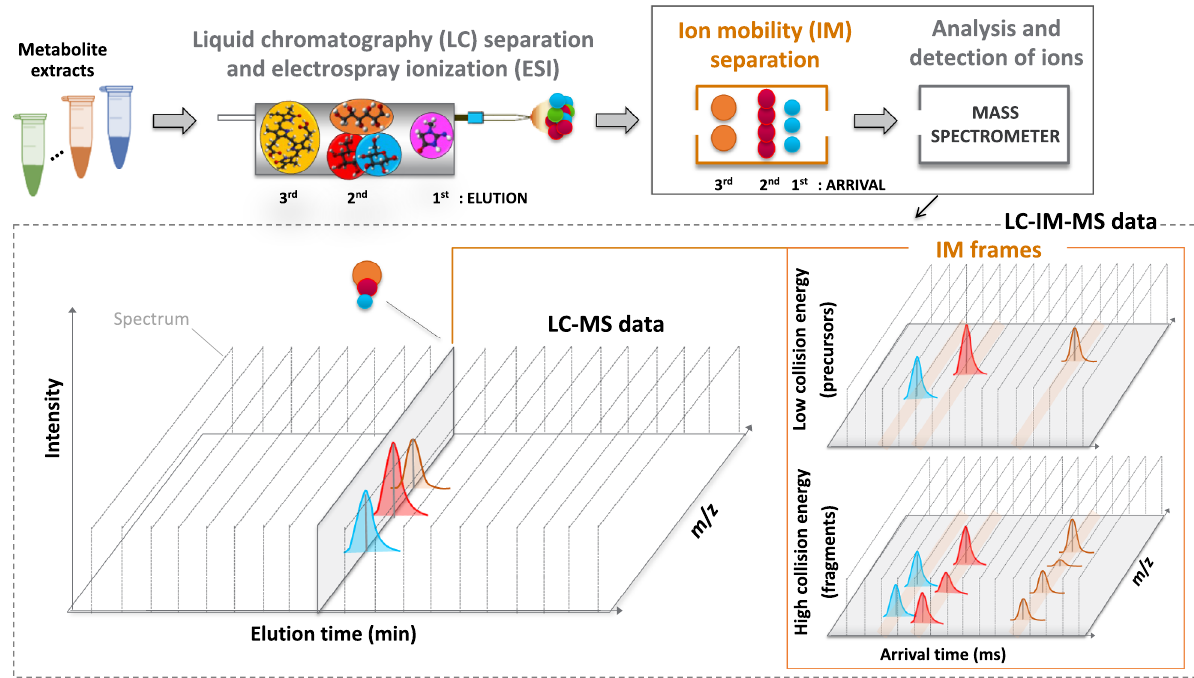
Fig.1|Analyticalwork fl owformultidimensionalmetabolitepro fi lingbyLC-IM- MS and data structure. Metabolite extracts are separated by LC, followed by IM, andanalyzedbyMSintheAll-IonsDIAmodewhichalternatesbetweenlowandhigh collision energies to capture precursor and fragment ion spectra within the same run. Spectra are represented by gray dashed lines. Rather than collecting a single spectrumateveryLCtimepoint,coelutingions(i.e.,withcloseelutiontimes)inthis